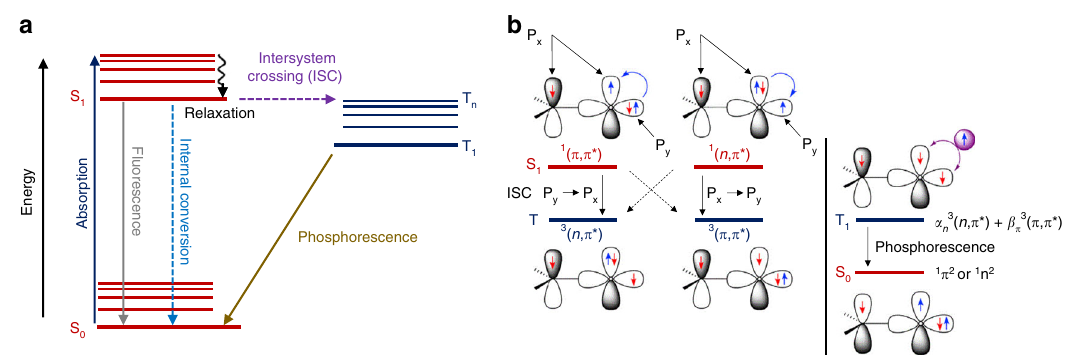
Fig. 1 Fundamental mechanism of organic room-temperature phosphorescence (RTP) phenomenon. a Jablonski diagram illustrating the different photophysical relaxation processes, particularly the intersystem crossing (ISC) between singlet and triplet states, which forms the basis for phosphorescence of organic luminophores. b Schematic illustration of the El-Sayed ’ s rule for ISC and its utilization for controlling phosphorescence decay rate based on the molecular-orbital hybridization of the lowest triplet states. b is adapted with permission from ref. 39 . Copyright (2016)